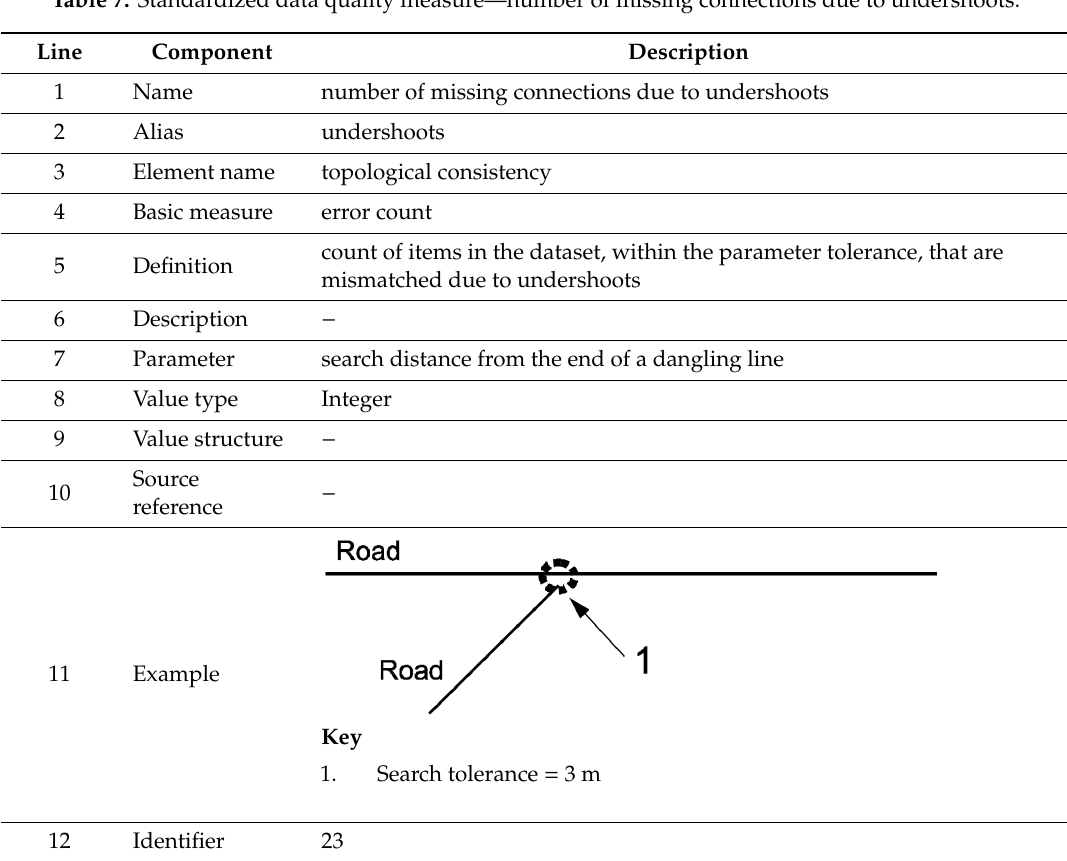
Figure 7. ISO 19157 Components of a data quality measure. Table 7. Standardized data quality measure—number of missing connections due to undershoots.